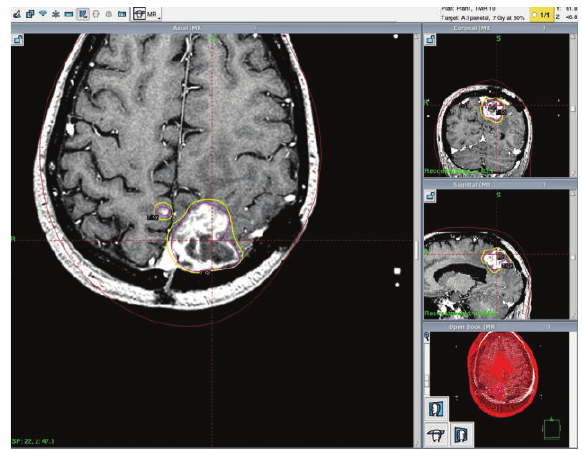
Figure 5: Treatment planning for one of the three fractions of 7Gy each to the 50% isodose line (21Gy total). This was his third and latest salvage GKRS which was administered 46 months after initial